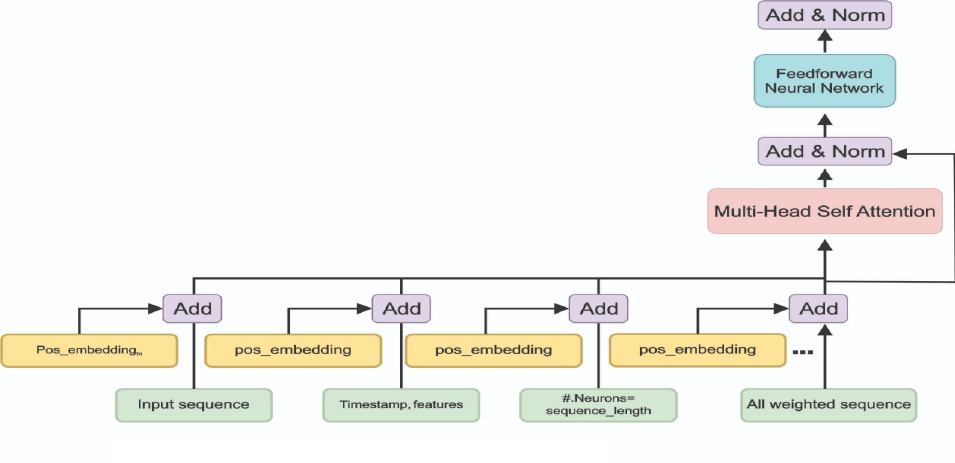
Figure 3. The working of the encoder